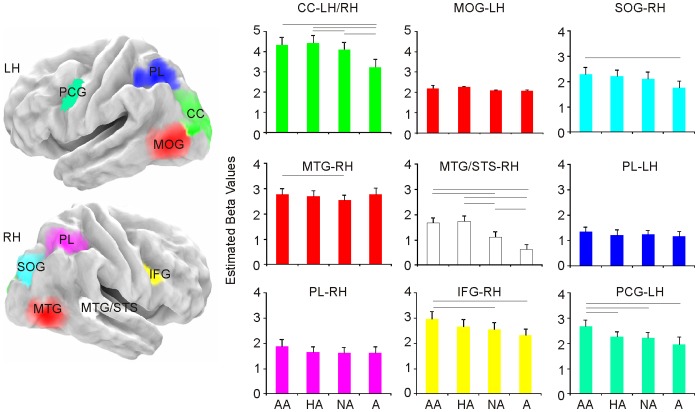
Regions showing different activation during the observation of any experimental condition compared with the intertrial baseline.Group activation data are rendered on the cortical surface of a “canonical” brain (Mazziotta et al., 1995). Plots represent estimated beta values for the AE and A conditions. Vertical bars indicate standard errors. Horizontal bars represent statistical differences.